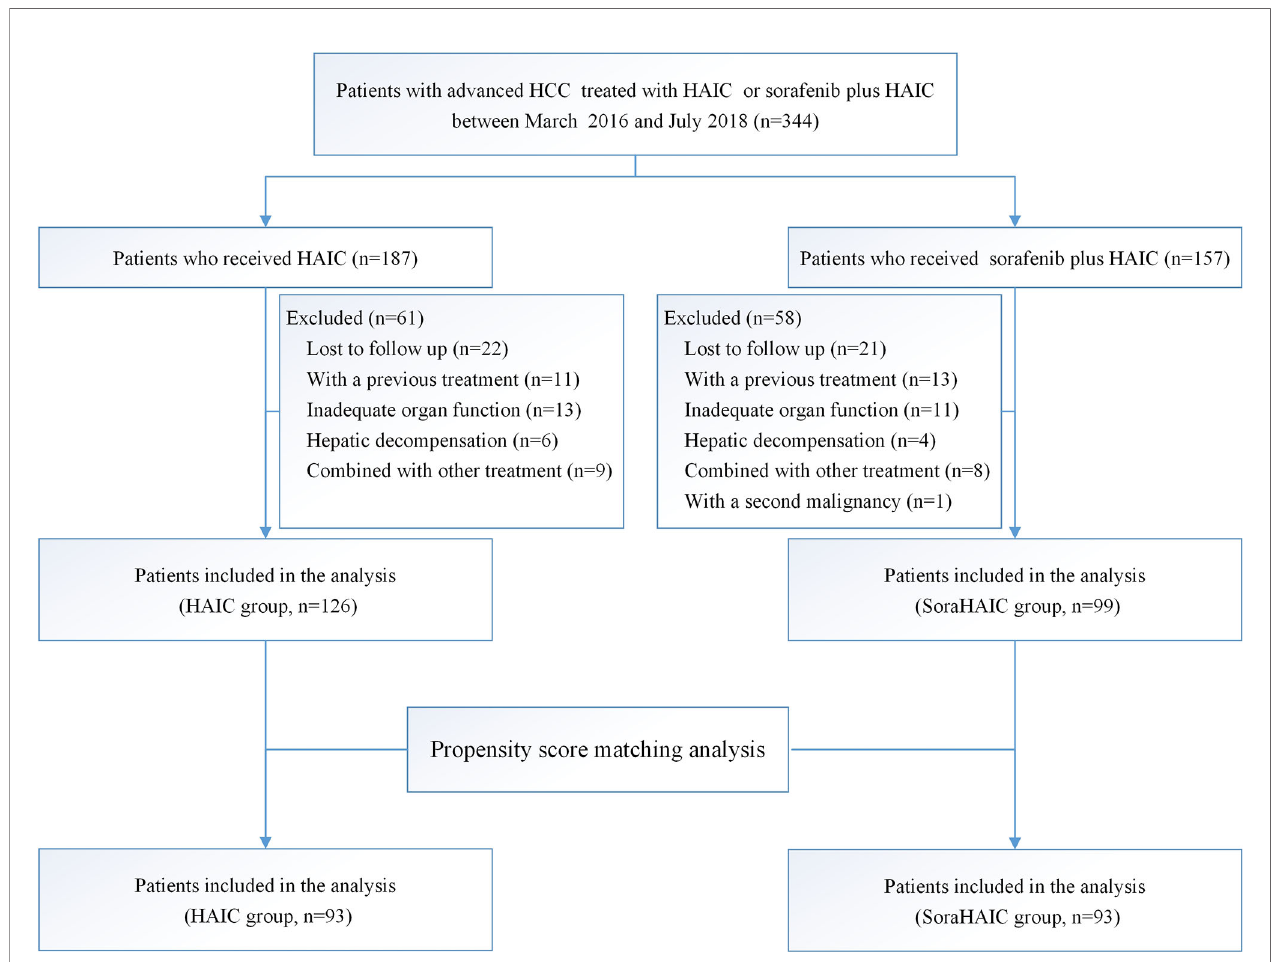
FIGURE 1 | Flowchart showing the patient selection process. HAIC, hepatic arterial infusion chemotherapy of oxaliplatin, 5- fl uorouracil and leucovorin; soraHAIC, hepatic arterial infusion chemotherapy of oxaliplatin, 5- fl uorouracil and leucovorin plus